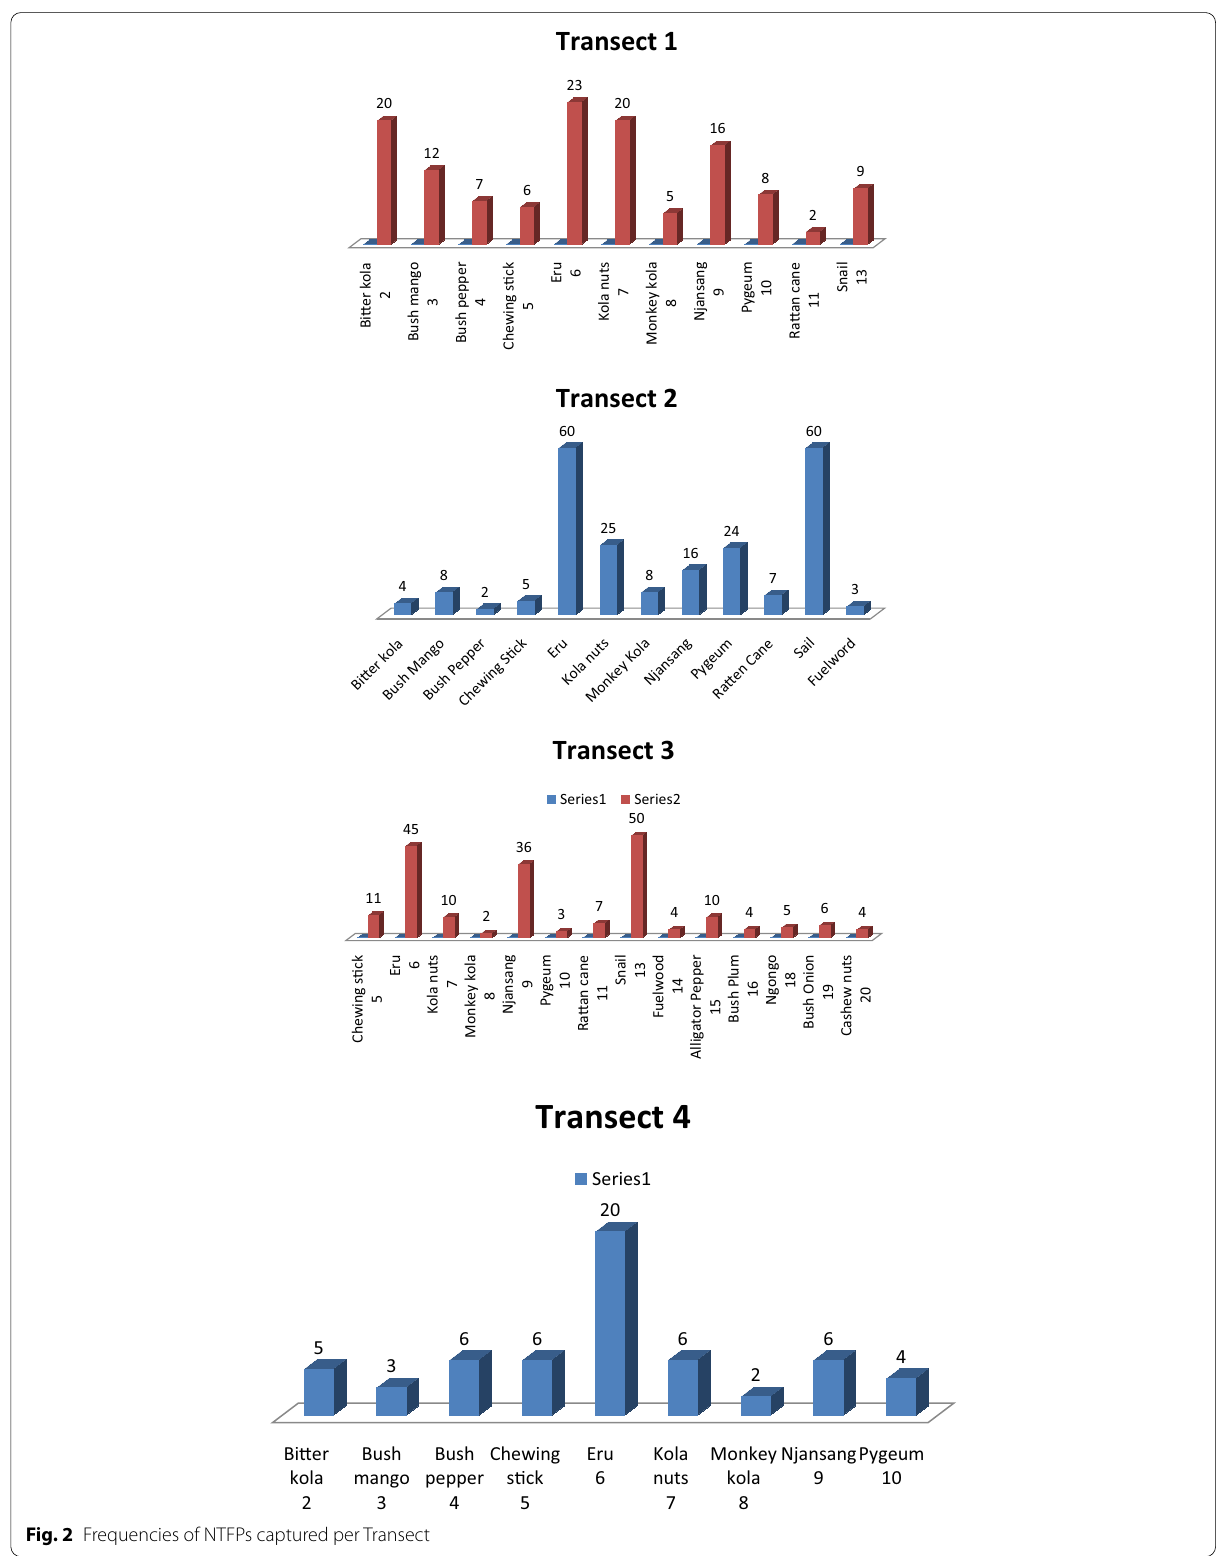
Fig. 2 Frequencies of NTFPs captured per